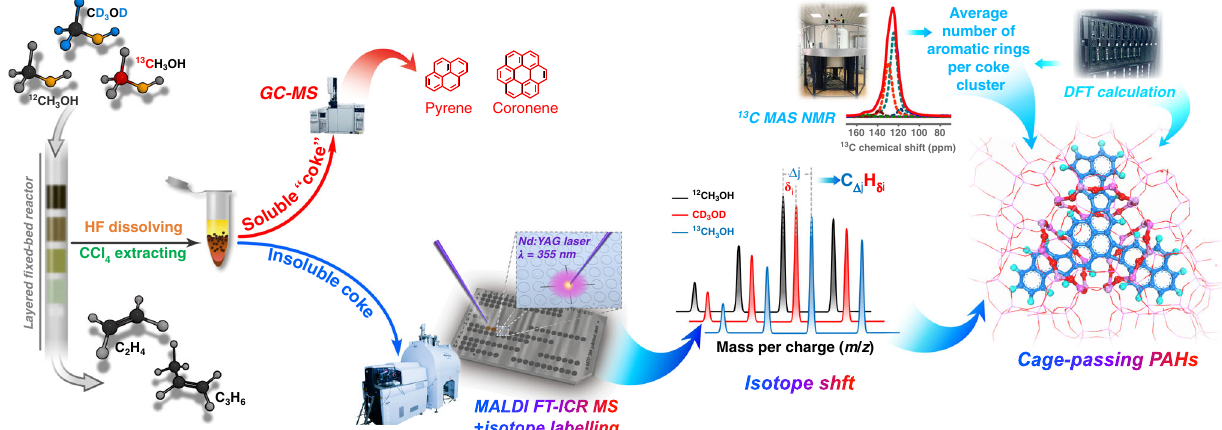
Fig. 1 Schematic illustration of an integrated strategy for deciphering full-spectrum PAHs. The proposed analytic method for heavier PAHs by combining the advanced MALDI FT-ICR MS with 13 C magic-angle spinning nuclear magnetic resonance (MAS NMR) spectroscopy and density functional theory (DFT) calculations. This method, together with the improved Guisnet ’ s method (see “ Methods ” ), allows for a full-spectrum analysis of coking species ranging from soluble “ coke ” to insoluble heavier PAHs. For the cage-structured zeolite- or molecular sieve-catalyzed reactions, certain amounts of branched hydrocarbons and active aromatic species can also be retained inside the cages of catalyst after reaction. So, in order to avoid misleading, we herein term the soluble “ coke ” being the organics dissolved in CCl 4 solvent and detectable by GC-MS, and the residual heavier counterpart being insoluble